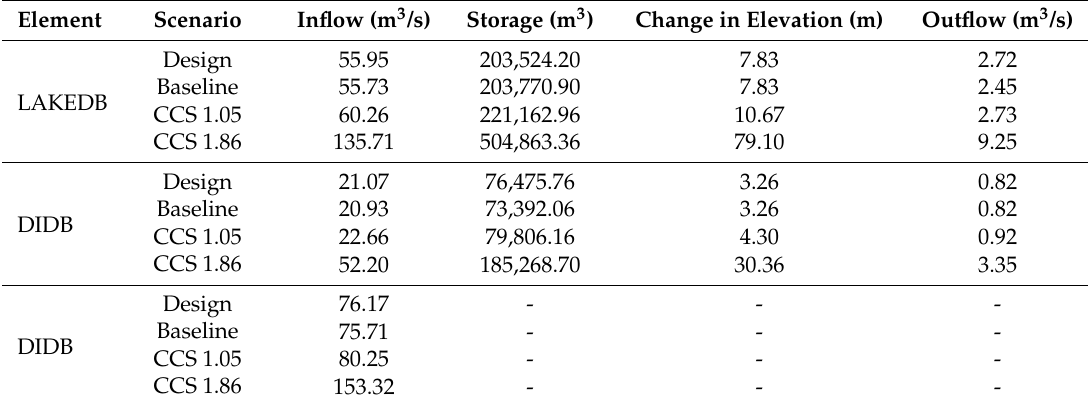
Table 3. Hydrological simulation outputs for the Lake Detention Basin (LAKEDB), Desert Inn Detention Basin (DIDB), and the junction point (JP) near the Linq Hotel parking